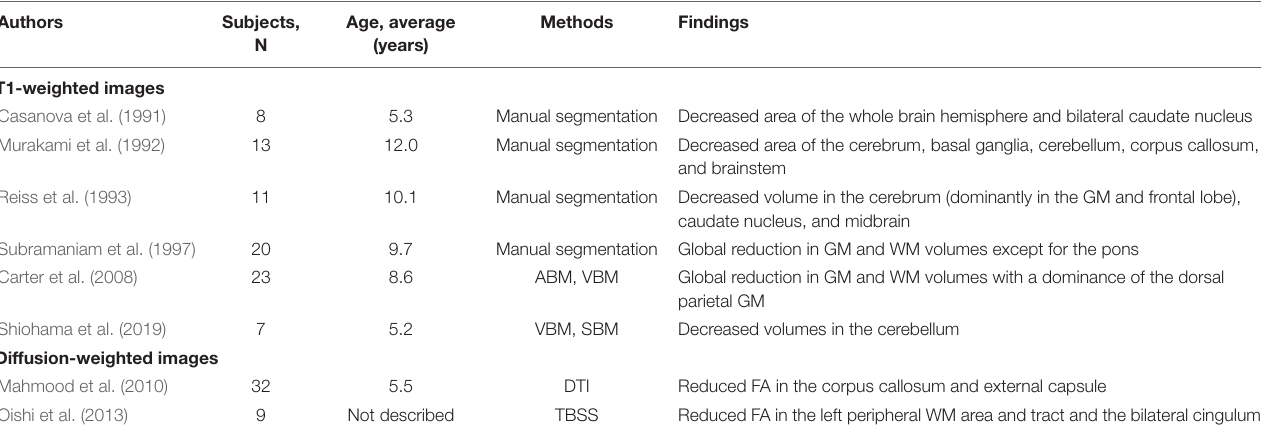
TABLE 1 | Quantitative structural brain magnetic resonance imaging studies in Rett